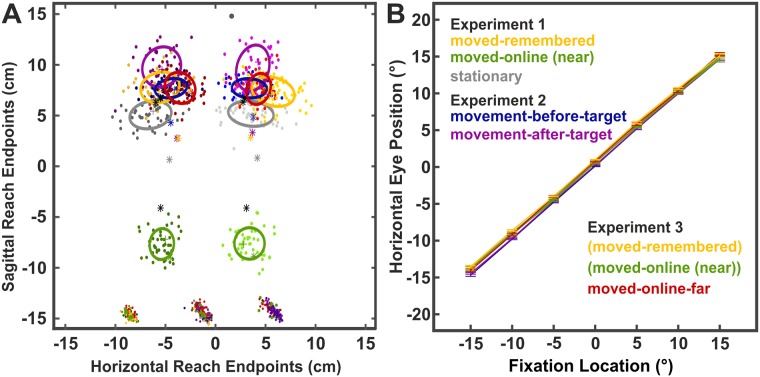
2D Reach endpoints and 50%-error ellipses of a single participant (A) and mean horizontal eye positions across participants (B) in all conditions.Colors indicate the conditions. (A) Colored ‘+’ symbols indicate the reach endpoints when gaze and target were aligned (RE = 0) for the exemplary participant; colored asterisks show the respective data averaged across all participants. Black asterisks indicate the physical target locations as obtained in a calibration procedure. Since the apparatus had to be changed for the moved-online-far condition, the physical target locations slightly differ from the other conditions (irrelevant for the analyses). In the moved-online (near) condition, the physical target locations were closer to the body of the participant (lower black asterisks). Colors of reach endpoints (dots) correspond to the respective ellipses, reaches to the right target are shown in slightly brighter colors than reaches to the left target. (B) Mean horizontal eye positions during the time of the touch response. Error bars display within-subjects standard errors.